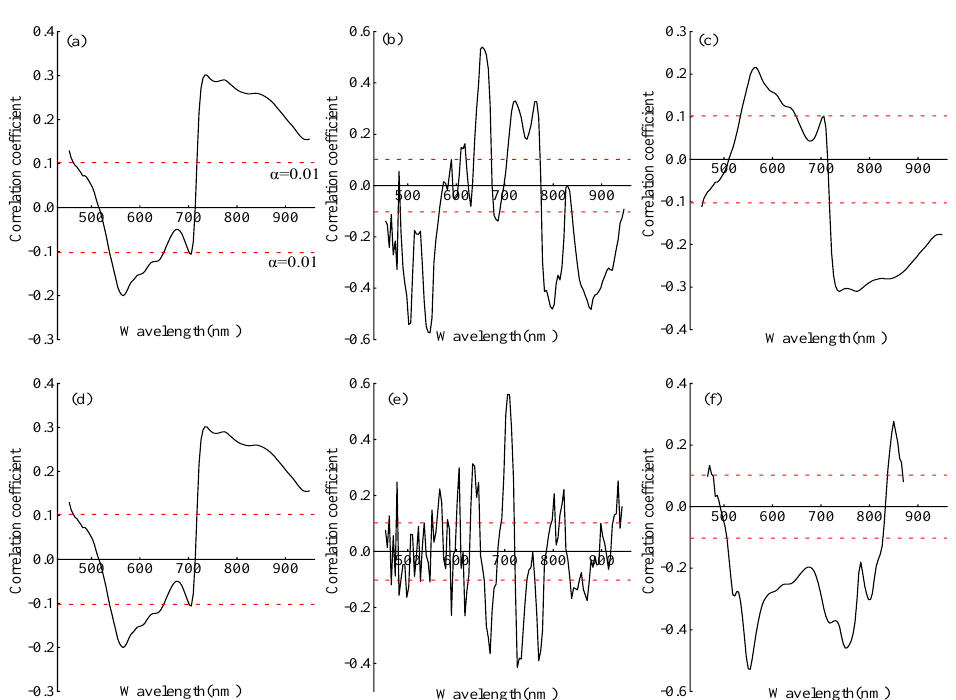
Figure 2. Relationship between PNC and single-band reflectance: ( a ) original reflectance, ( b ) the first derivative, ( c ) the logarithm of the reciprocal of the spectra, ( d ) the standard normal variate transform, ( e ) the second derivative, and ( f ) continuous removal. The dashed lines indicate the critical correlation coefficient at α = 0.01. Table 3. Statistics of bands sensitive to potato PNC and with single-band